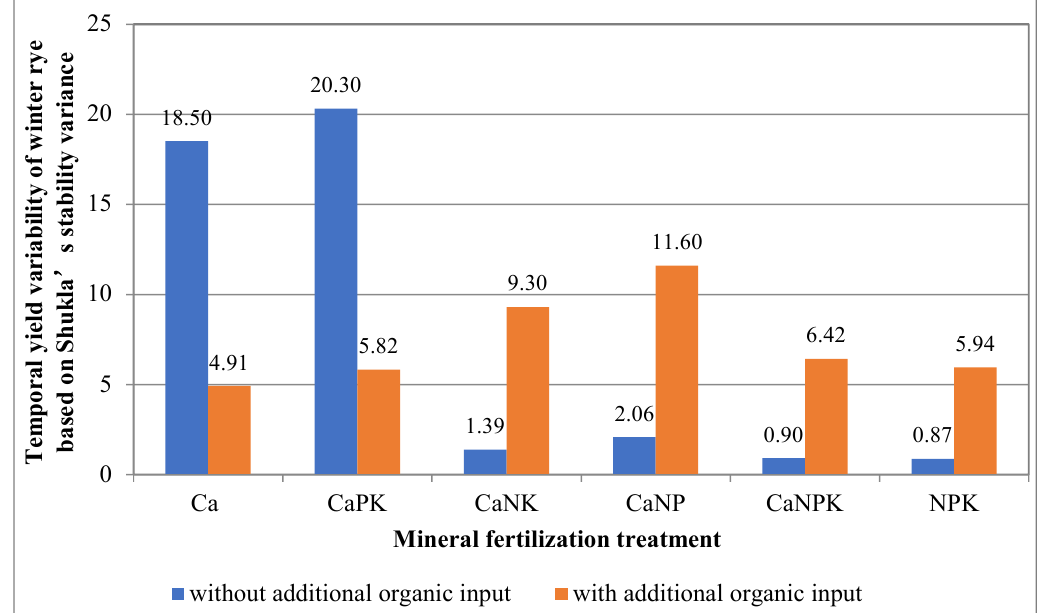
Figure 3. Temporal yield variability of winter rye depending on the mineral fertilization treatment without and with additional organic input (Skierniewice LTE 1966–2015). Higher values indicate more variable yields (year-to-year fluctuations); lower values indicate more stable yields.